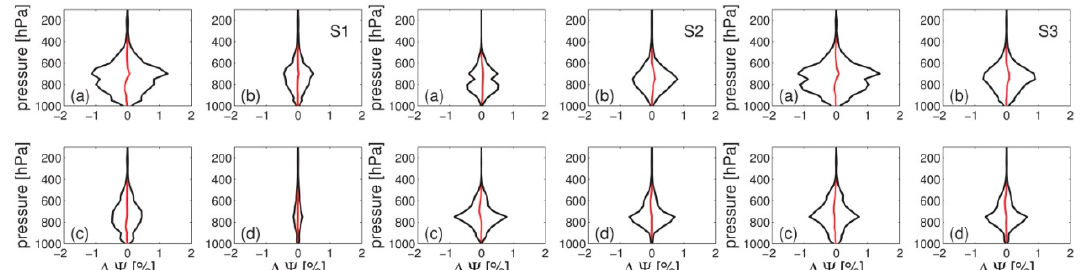
Figure 10. The mean (red) and one-sigma (black) refractivity deviation in percent between the background and the analysis as a function of the pressure. Left panel: ZTDs are assimilated. Middle panel: Horizontal delay gradients are assimilated. Right panel: ZTDs and horizontal delay gradients are assimilated. In each panel the four plots correspond to the grid points surrounding the station Potsdam. The labels (a), (b), (c) and (d) correspond to the grid points to the north-west, north-east, south-west and south-east respectively. GNSS ZTDs and horizontal delay gradients from the G-Nut/Tefnut software for the single station Potsdam are assimilated four times per day (0, 6, 12, 18 UTC) for a period of two months (June and July, 2017).